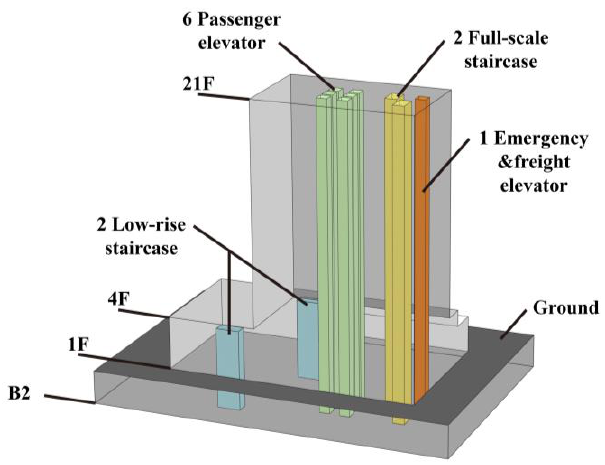
Figure 4. The vertical air flow paths in building interior.